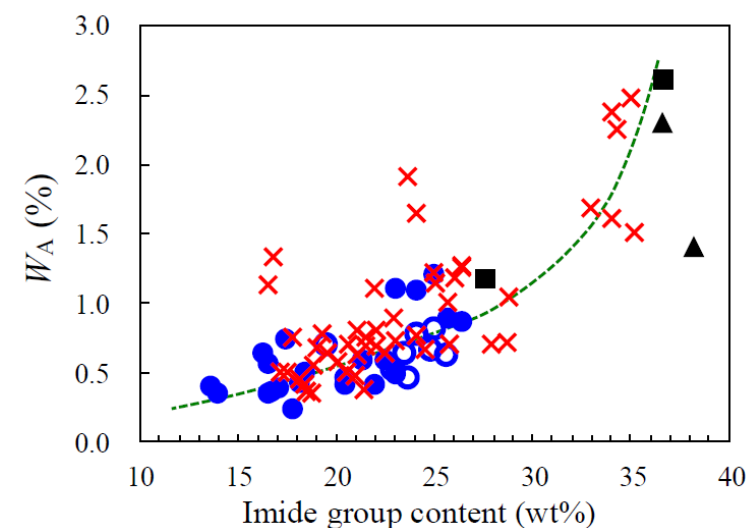
Figure 9. Relationship between the imide content and the extent of water absorption for PEsI or PI films: (●) homo PEsIs developed in this work, ( ○ ) the related PEsI copolymers, ( × ) conventional PEsIs that we have examined previously, ( ■ ) PMDA-based conventional PIs, and ( ▲ ) commercially available PI films. The data for fluorine- and amide-containing PEsIs are not included in this figure.